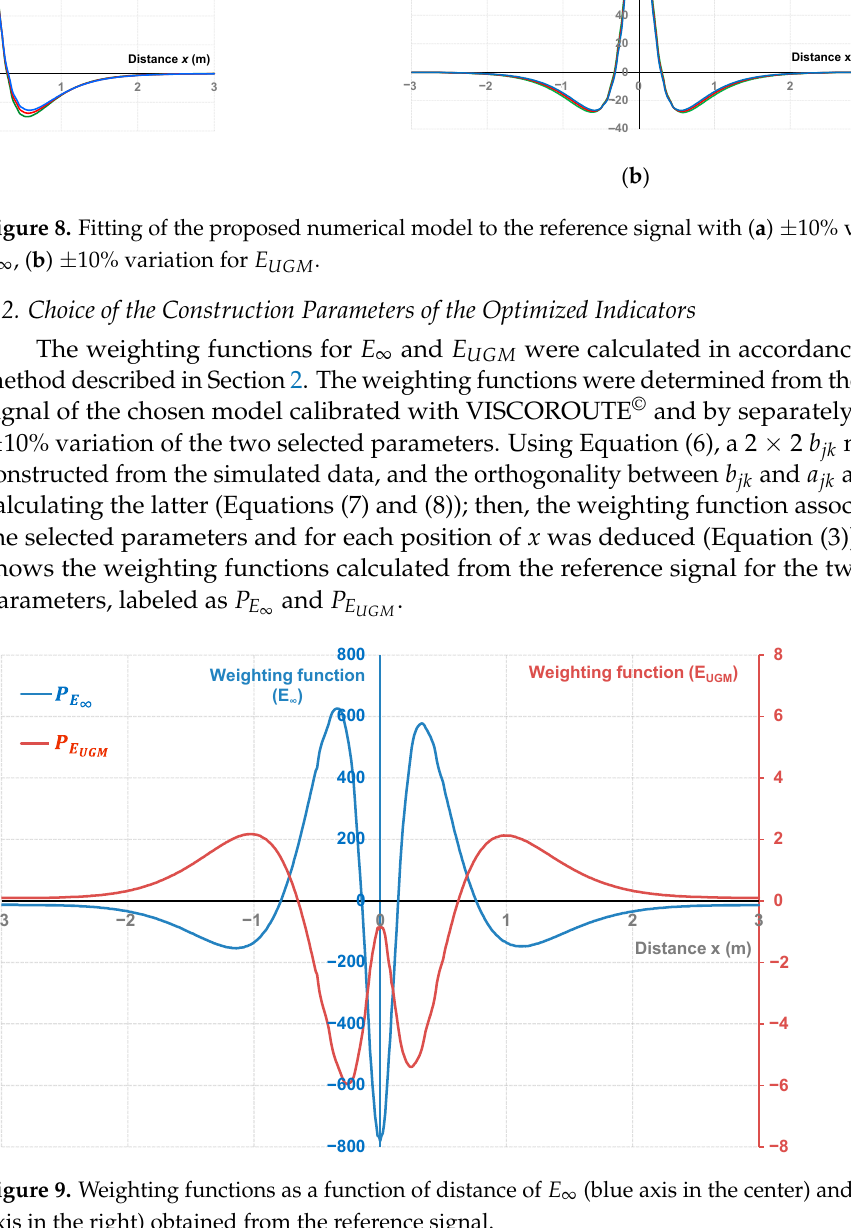
Figure 9. Weighting functions as a function of distance of 𝐸 (cid:2998) (blue axis in the center) and 𝐸 (cid:3022)(cid:3008)(cid:3014) (red axis in the right) obtained from the reference signal.